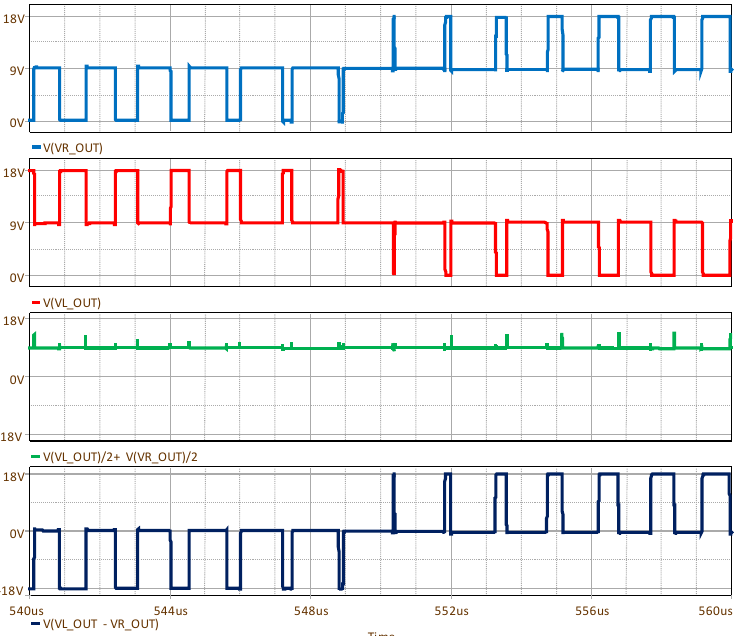
Figure 8. SPICE simulation of the load current and output voltages in DM and CM modes of the Class-BD amplifier with constant voltage at the CM output (in Figure 5).